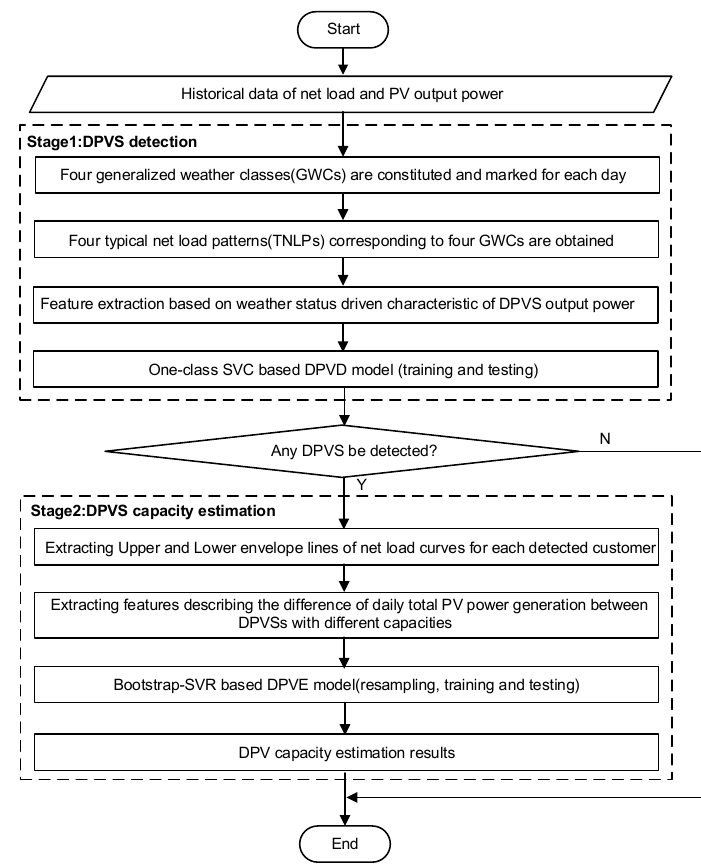
Figure 1. Framework of the proposed two-stage DPVSCE approach.